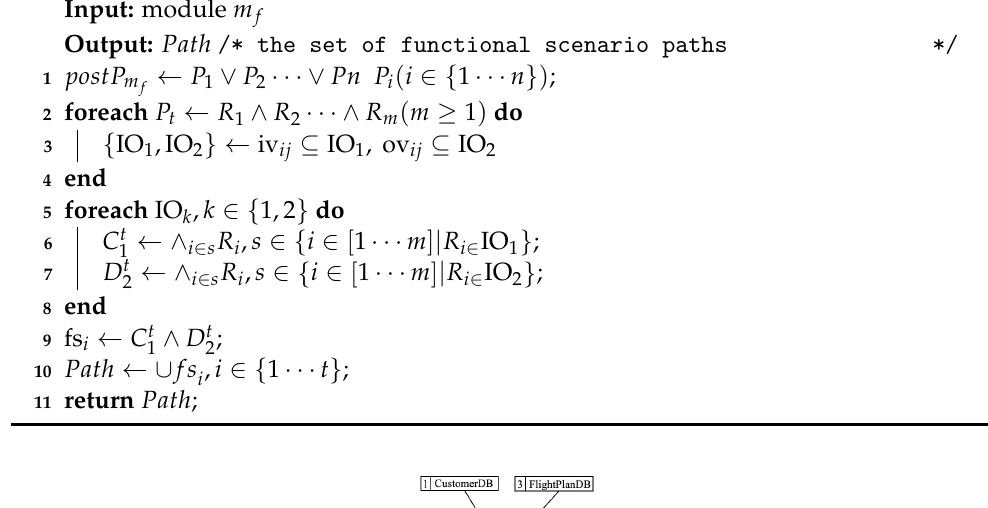
Algorithm 2 Feature Scenario Paths Generation